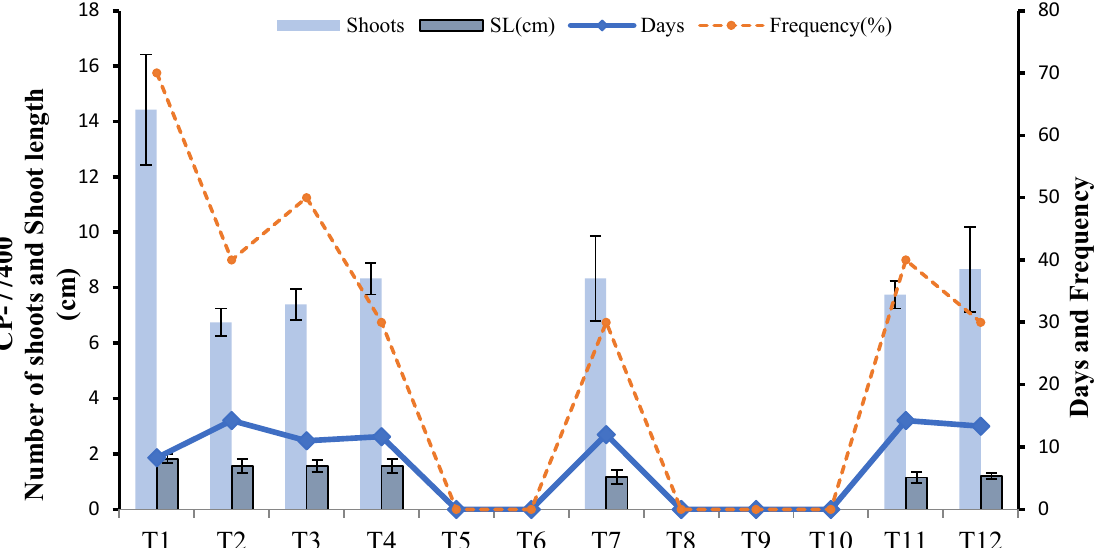
Figure 9. Effect of different media compositions on shoot induction in terms of shoot length, number of shoots, number of days, frequency in Cp-77400.